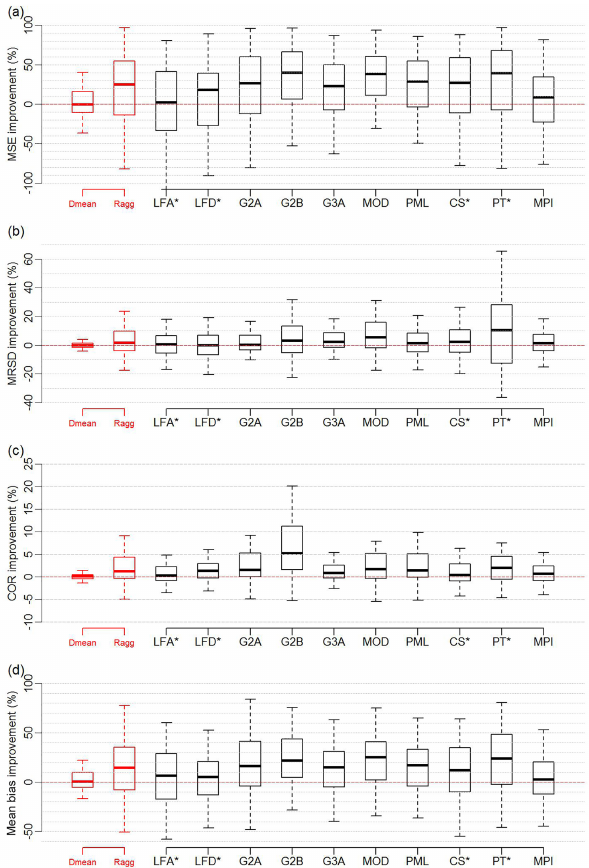
Figure 12. Box and whisker plots displaying the percentage im- provement that the weighting provides when MPIBGC is excluded from the weighting ensemble in the one-site out-of-sample test for four metrics: MSE (a) , MRSD (b) , COR (c) and mean bias (d) , when compared to the equally weighted mean ( D mean ) of the di- agnostic ensemble, aggregated reference ensemble ( R agg ) and each member of the reference ensemble. Products marked with ∗ have limited spatiotemporal availability relative to the diagnostic ensem- ble, and testing against the LFA, LFD, CS and PT products was limited to 110, 108, 108 and 72 sites